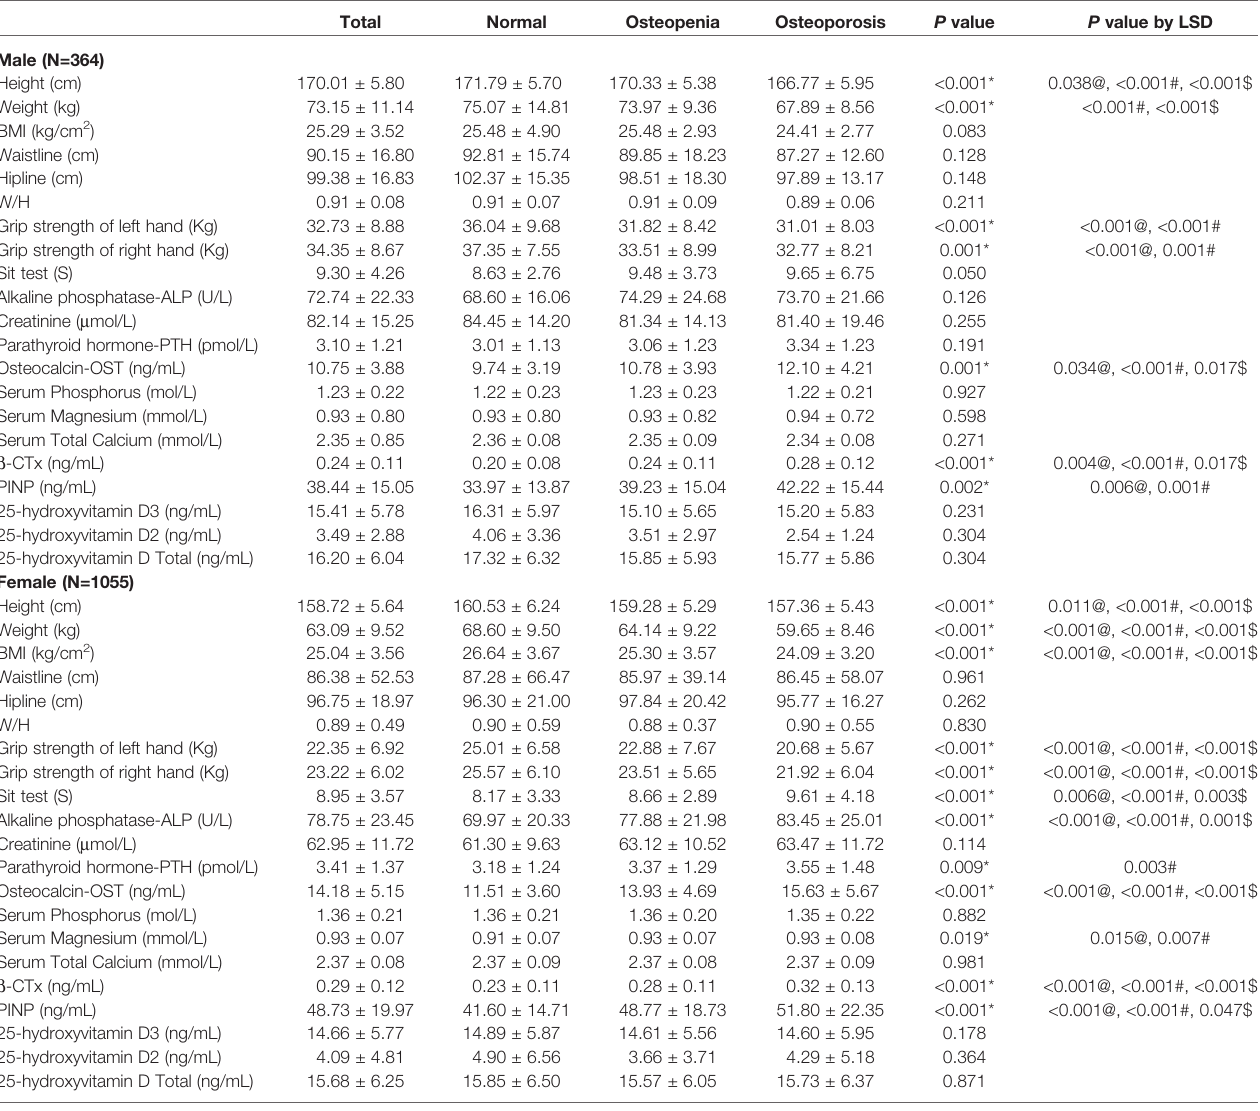
TABLE 5 | Physical and chemical indexes by gender and osteoporosis diagnose. Total Normal Osteopenia Osteoporosis P value P value by